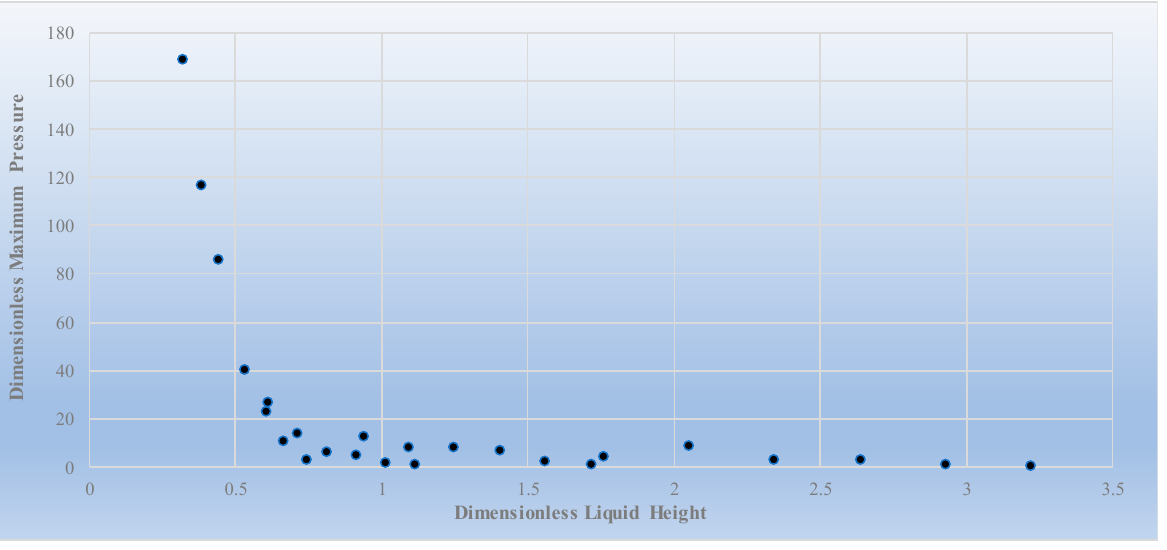
Figure 10. Dimensionless maximum pressure versus dimensionless liquid height for the observed (CFD) data.